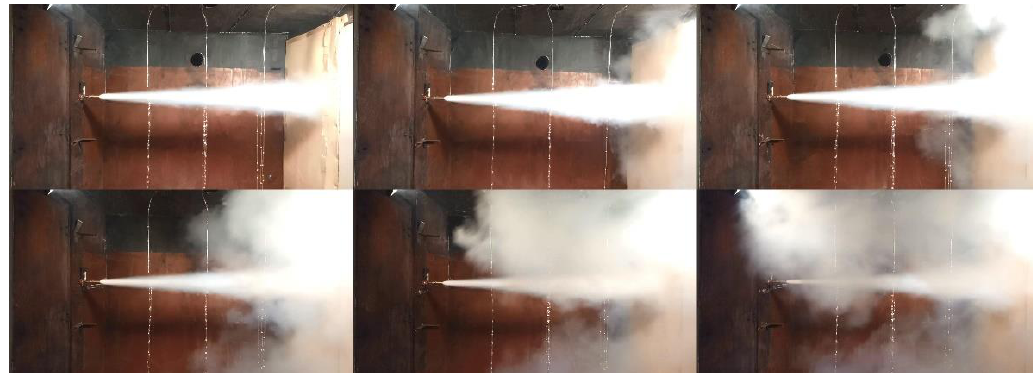
Figure 14. Concentration versus time at points 9, 10, 11, and 12 in Section III in the case of 3.45 MPa.